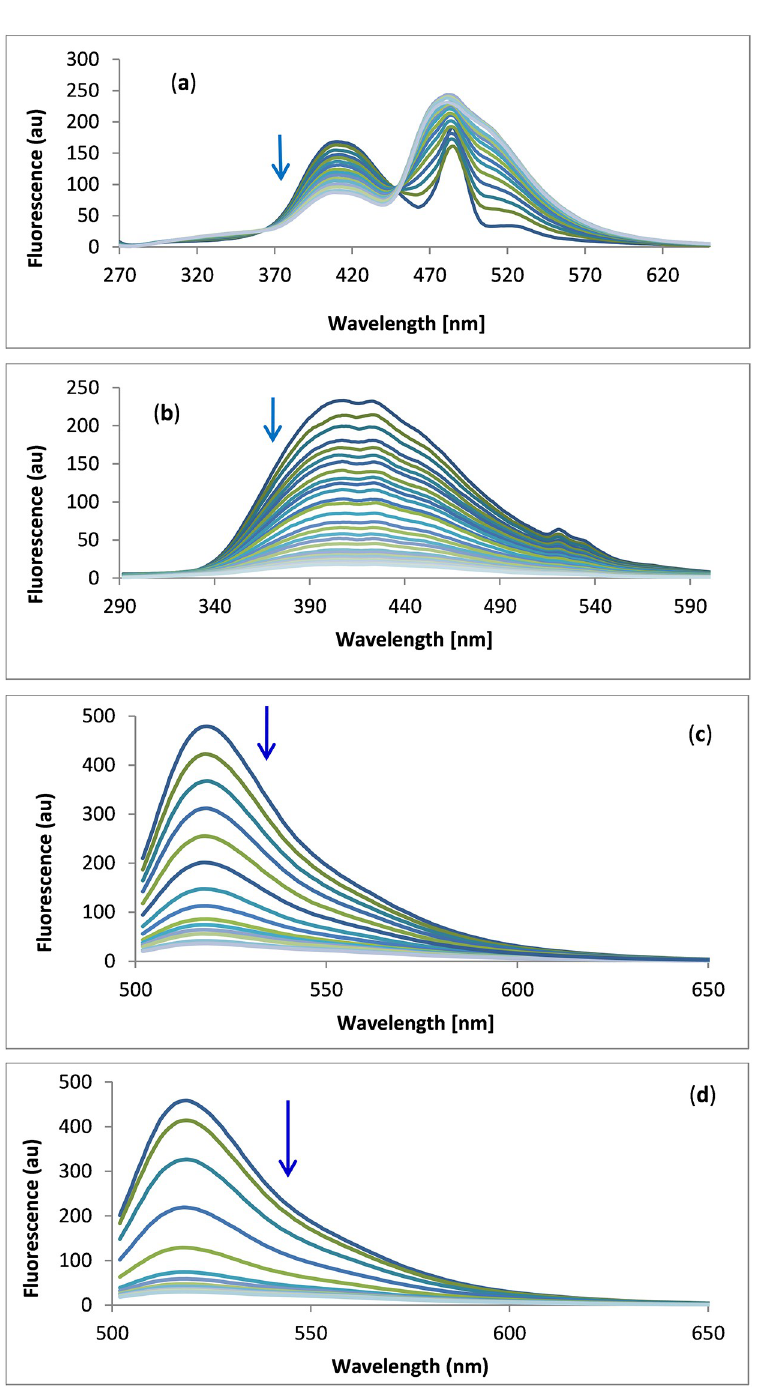
Fig 2. Fluorescence titrations of (a) A 5 × 10 − 6 M GW-2974 with human telomeric G-quadruplex DNA (1.33 × 10 − 4 M). (b) A 5 × 10 − 6 M of SCH-442416 with human telomeric G-quadruplex DNA (1.33 × 10 − 4 M). (c) A 2 × 10 − 6 M fluoresceine-labelled G-quadruplex DNA with 1 × 10 − 4 M GW-2974. (d) A 2 × 10 − 6 M fluorescein-labelled G- quadruplex DNA with 1 × 10 − 4 M SCH-442416. All titrations were carried out in Tris–KCl buffer, pH 7.4. Fluorescein- labelled G-quadruplex DNA had an excitation wavelength of 494 nm and emission wavelength of 518 nm.